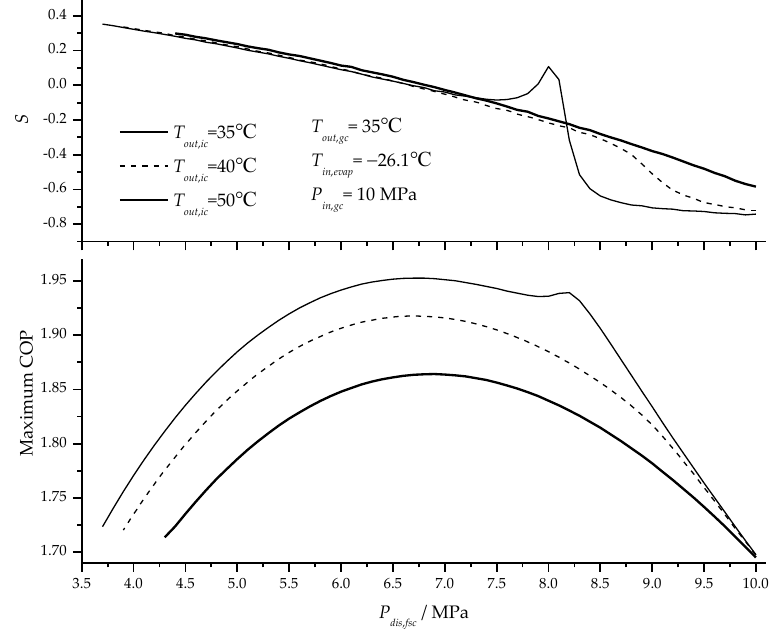
Figure 12. Sensitivity of COP to inter-stage pressure at various intercooler outlet temperatures.